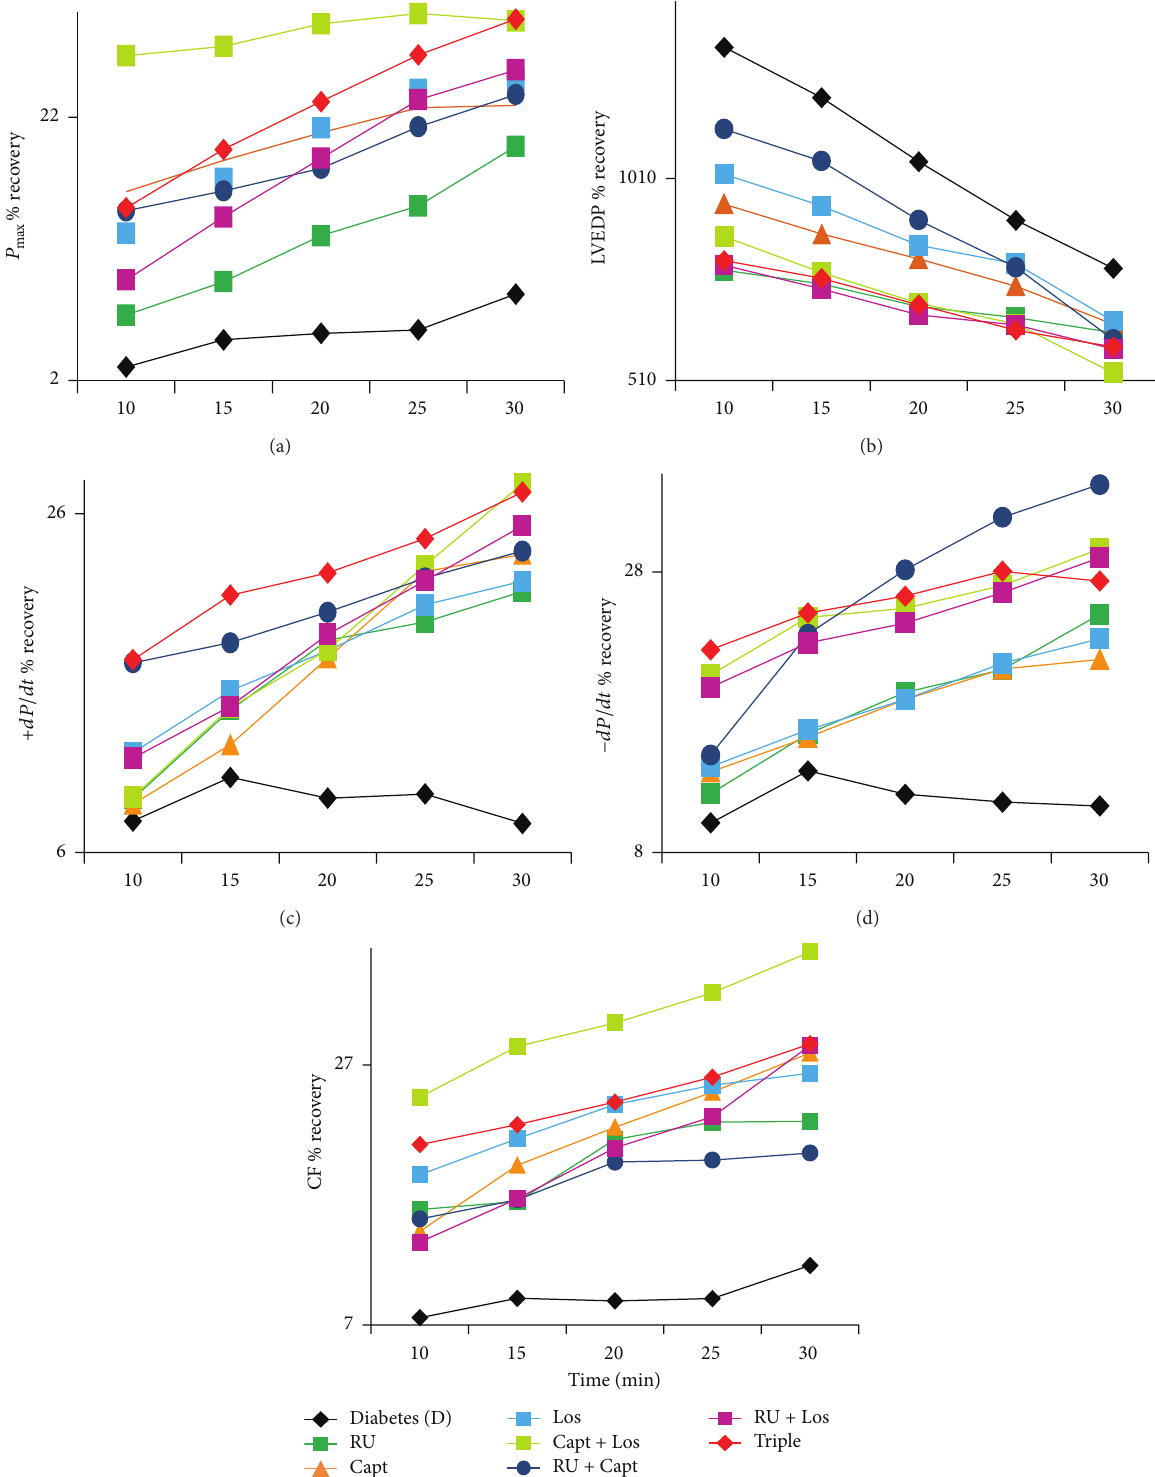
Figure 3: The effect of drugs given before ischemia on % recovery in cardiac function versus reperfusion time for (a) 𝑃 max , (b) LVEDP, (c) +𝑑𝑃/𝑑𝑡 , (d) −𝑑𝑃/𝑑𝑡 , and (e) CF in diabetic hearts. RU: RU28318; Capt: Captopril; Los: Losartan; Triple: RU28318 + Captopril + Losartan; 𝑃 left ventricular developed pressure; LVEDP: left ventricular end-diastolic pressure; +𝑑𝑃/𝑑𝑡 : positive derivative of pressure; −𝑑𝑃/𝑑𝑡 : negative derivative of pressure; CF: coronary flow; % 𝑅 : % recovery: (reperfusion/baseline) ×